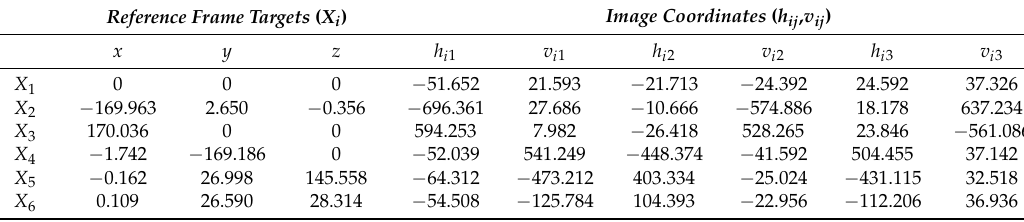
Table 1. Input data for extrinsic computing: 3D coordinates ( x , y , and z in mm, for X 1 to X 6 ) for coded targets on reference frame, and image coordinates ( h ij and v ij in pixels, for image j = 1 to 3). Reference Frame Targets (X i )